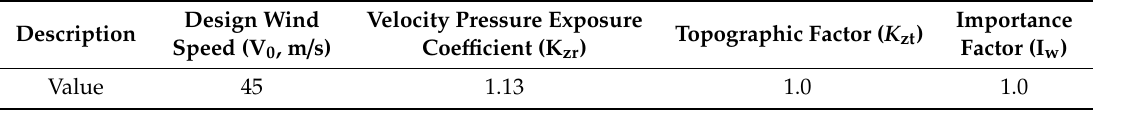
Table 3. Wind load variables.